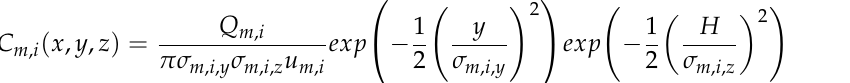
Figure 5. Spatio-temporal path for an ongoing moving ship.